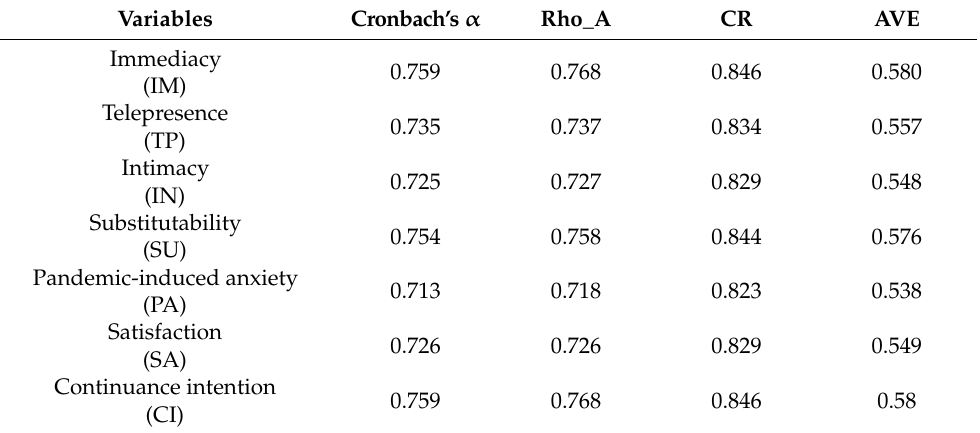
Table 3. Assessment of the reliability and validity.